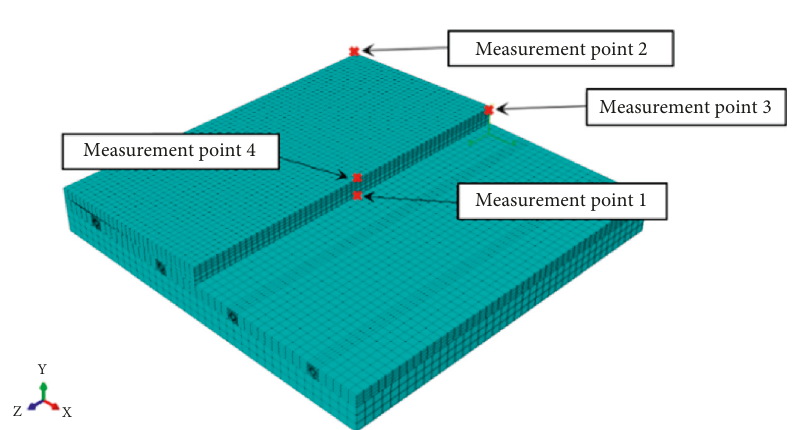
Figure 10: Layout of temperature measuring points in the numerical